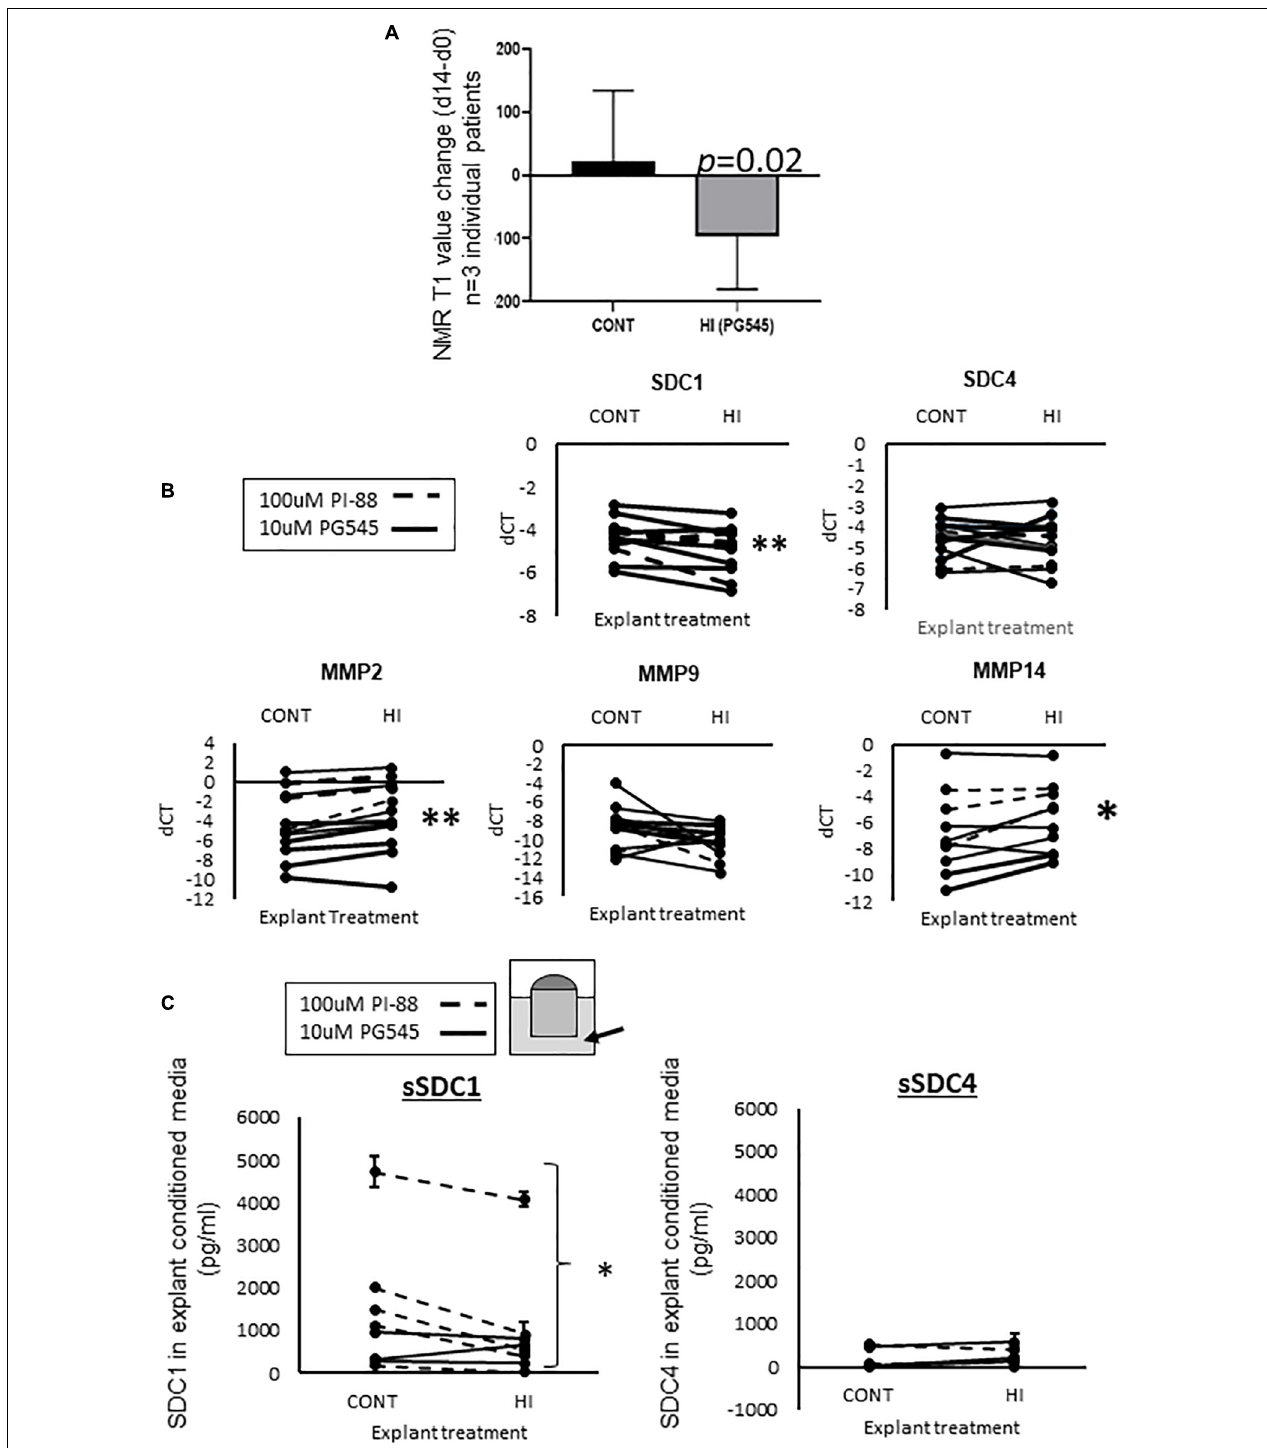
FIGURE 4 | (A) MD change (d14–d0) in PG545 treated mammary tissue explants as measured by the change in NMR T1 values, Student’s paired T -test was used to determine significance, with p -values displayed on graph, n = 3 individual patient tissue tested. (B) RT-qPCR data from HI treated explants. Dotted line denotes 100 µ M PI-88 treated explants, where control is 100 µ M Fondaparinux; solid line denotes 10 µ M PG545 treatment, where control is media alone. More gene expression data is found in Supplementary Figure S3 . Delta CT values are plotted, determined using using L32 as the housekeeper gene. (C) Inhibition of HPSE led to a decrease in the abundance of shed SDC1 in explant conditioned media (Student’s paired T -test used to determine significance, ∗ denotes p < 0.05). Dotted line: PI-88, solid line: PG545. For SDC1, n = 8 pairs, for SDC4, n = 6.